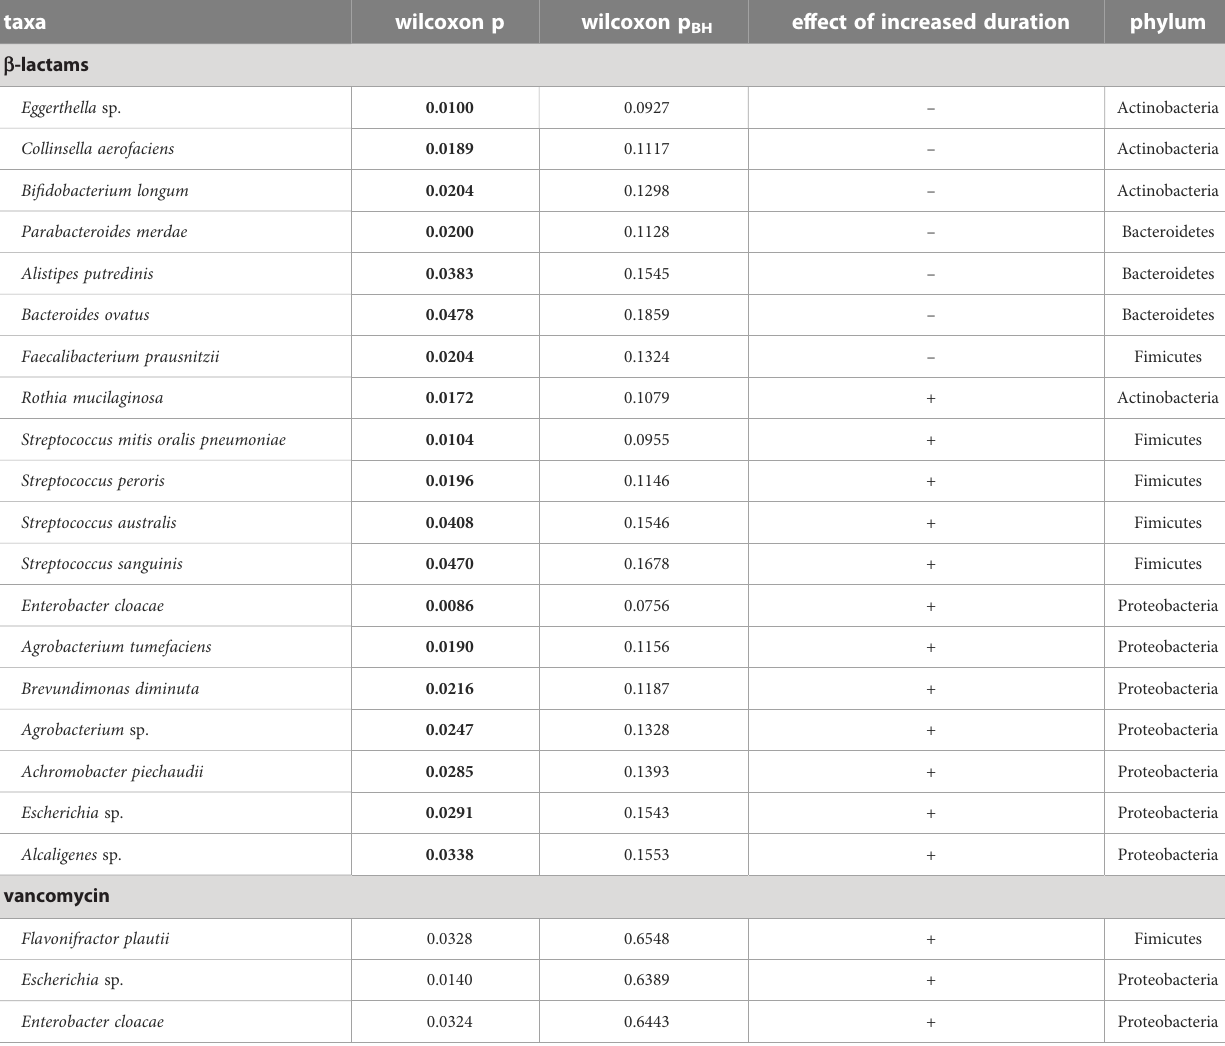
Bolded values indicate values <0.05. Analyses were performed on the reduced patient dataset (see Supplemental Table S3 for breakdown of samples and patients per